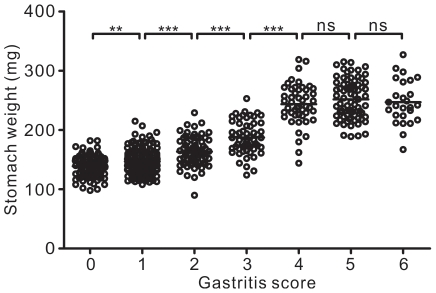
Significant difference in stomach weight among gastritis scores.Thymectomy was performed on BALB.B6-Gasa congenic mice on day 3 of age and mice killed at 12 weeks. The severity of autoimmune gastritis and stomach weight was determined. Data pooled from at least 100 independent thymectomies. Each circle represents the data from one mouse. Mann-Whitney U test was used; bars, mean, **, P<0.01 and ***, P<0.001.